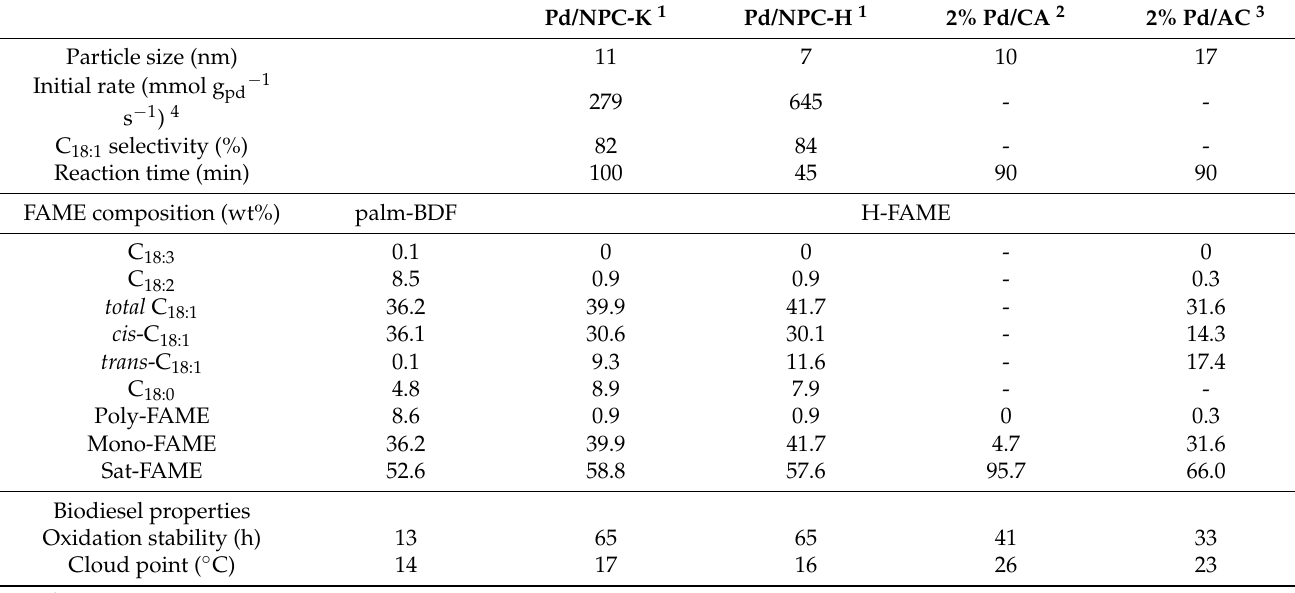
Table 5. Initial rate, FAME composition, and biodiesel properties of palm-BDF and H-FAME over the prepared Pd/NPC catalysts at a poly-FAME conversion level of 90%.